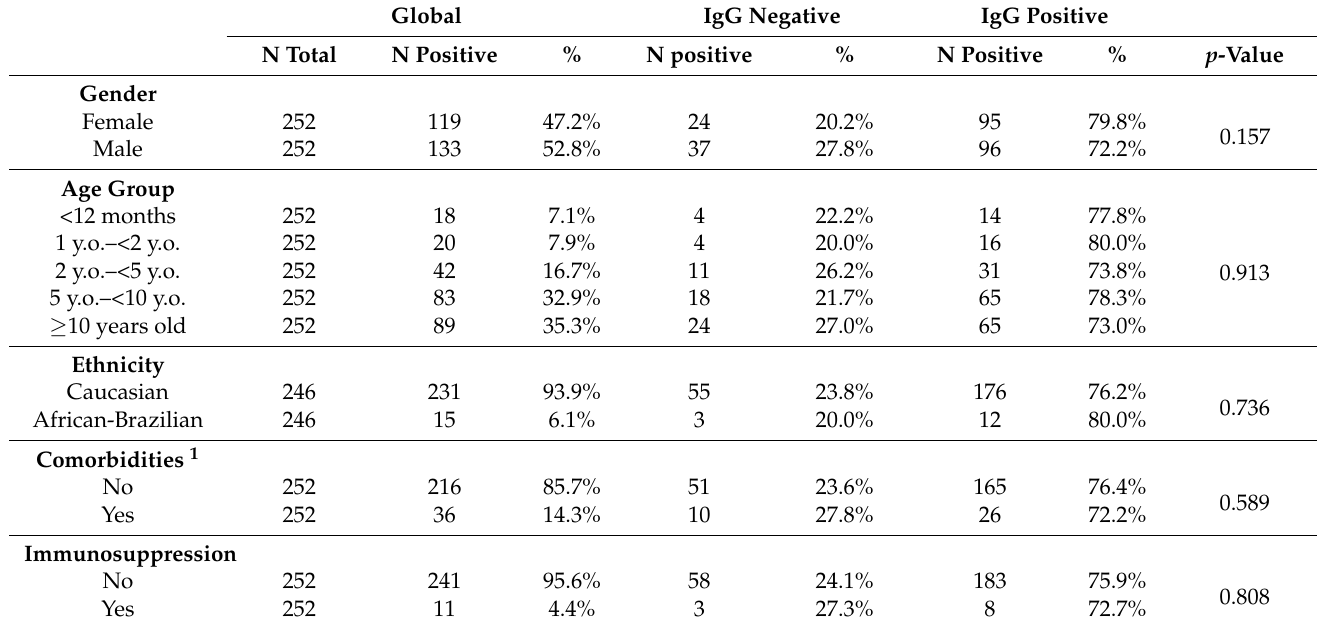
Table 1. General characteristics of the 252 children assessed for IgG-specific measles